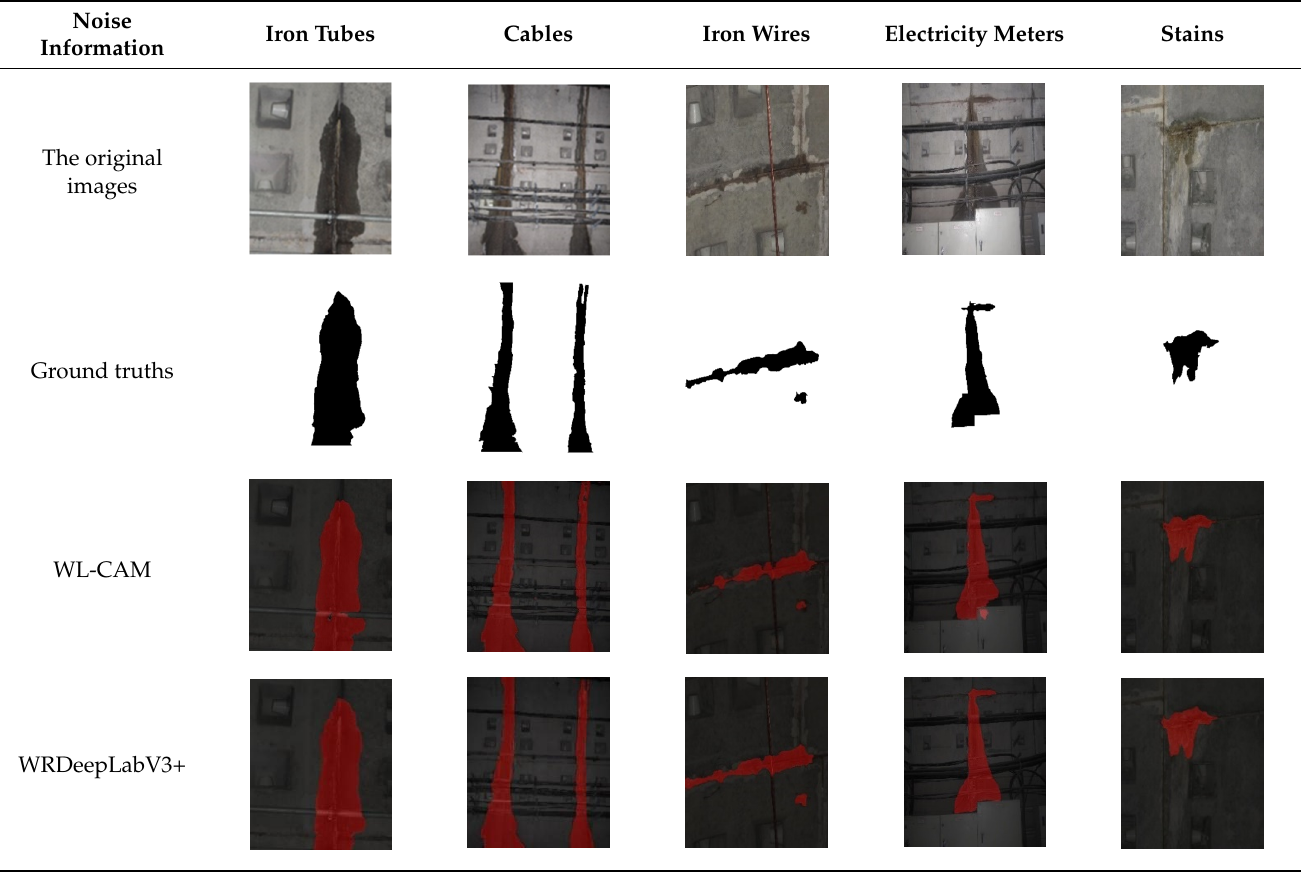
Table 6. Water leakage segmentation effects of WL-CAM and WRDeepLabV3+ on different noises.